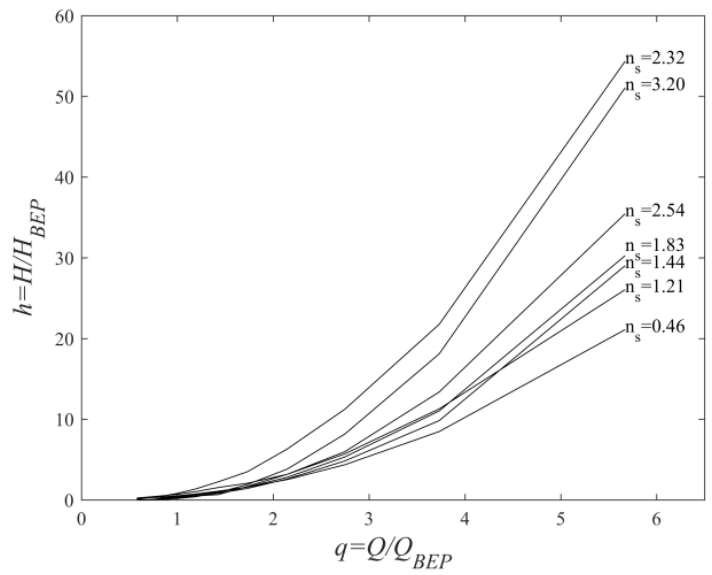
Figure 4. Dimensionless curves of PATs [18].